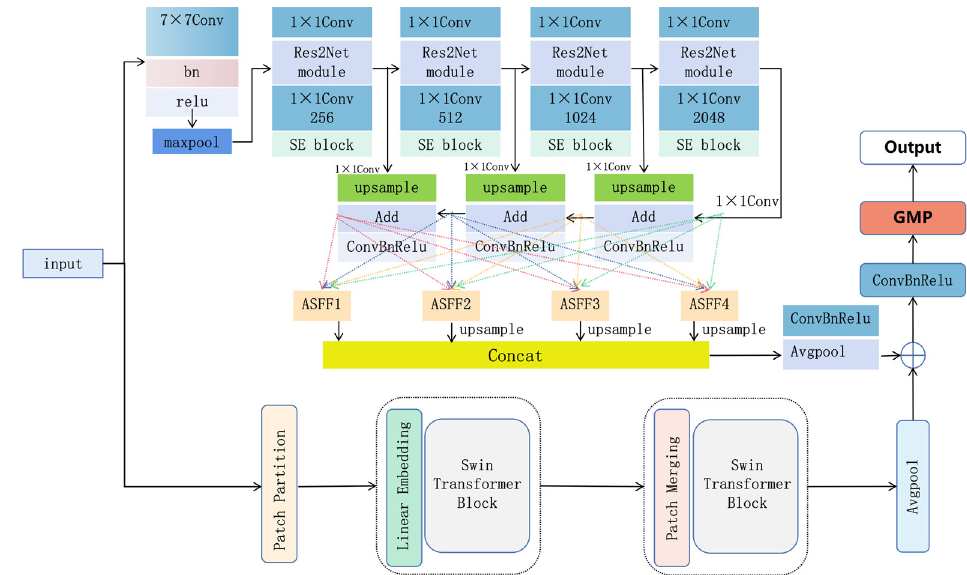
Figure 2. Network structure.